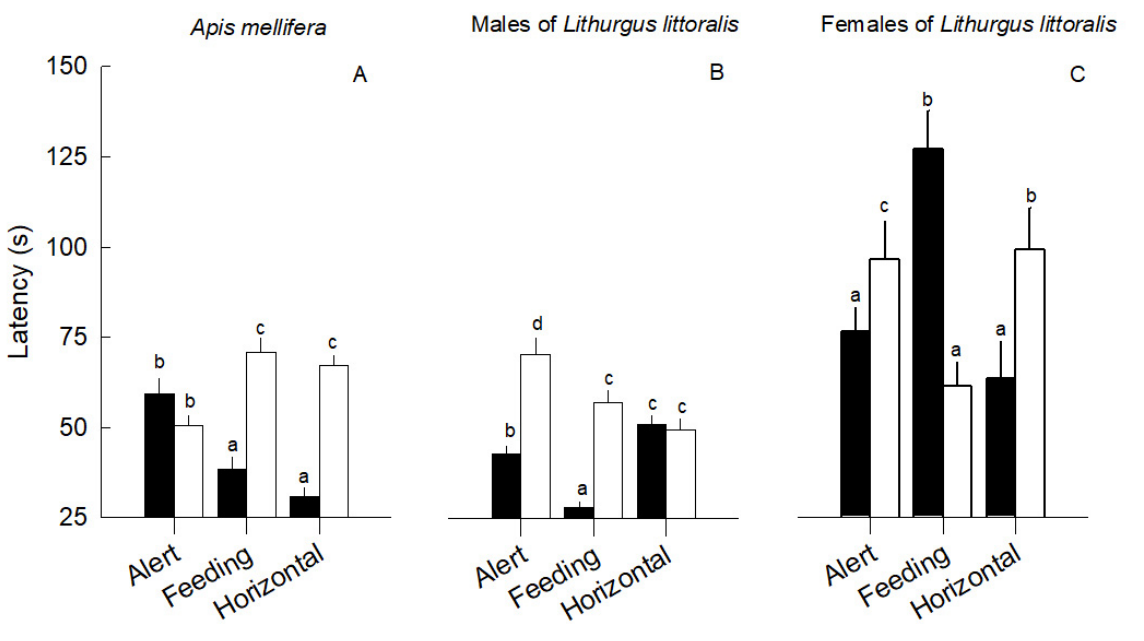
Figure 5. Mean response time in seconds (latency) ( M ± SE ) of ( A ) Apis mellifera , ( B ) Lithurgus littoralis male and ( C ) female to the presence of A. mellifera dummy model bees (open bars) and L. littoralis dummy model bees (filled bars) for the three body position treatments above flowers of Opuntia huajuapensis. Small letters (a, b, c, and d) on the bars show the significant differences between mean values.